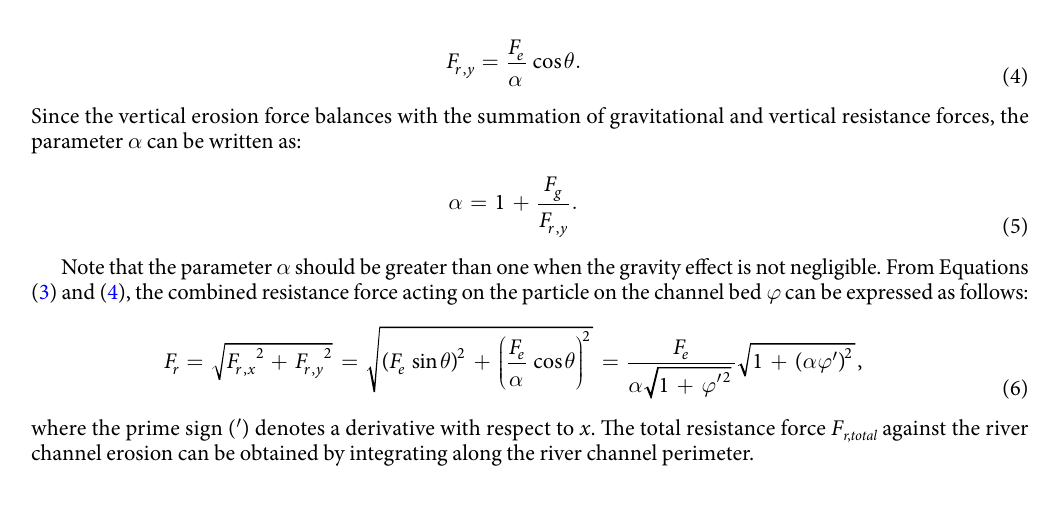
expected for a straight prismatic channel.